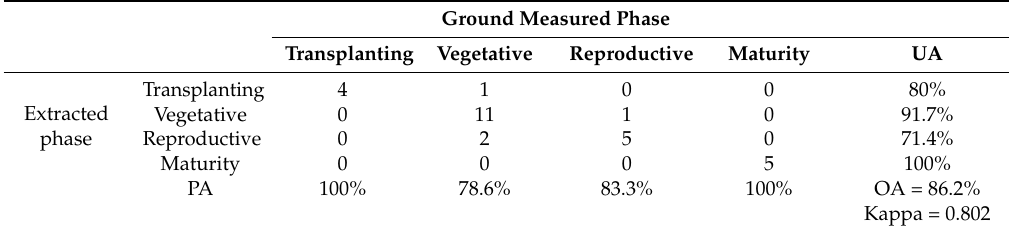
Table 4. Confusion table derived by validation data. UA stands for user's accuracy, PA producer's accuracy, and OA overall accuracy. Kappa denotes kappa coefficient.